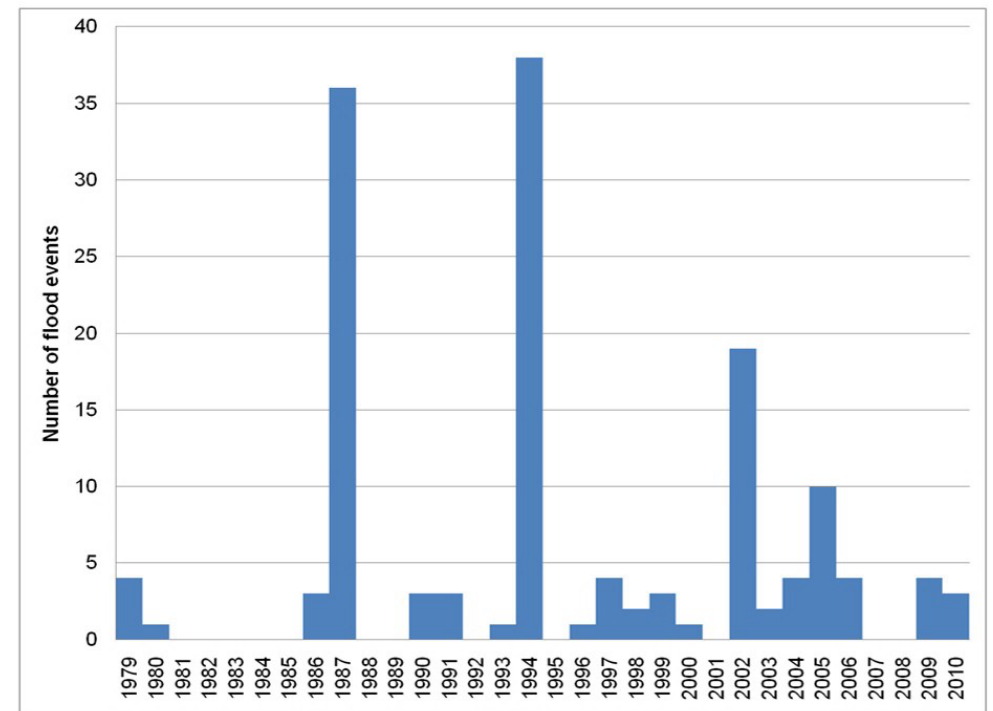
Figure 4. The annual distribution of flood events from 1979–2010.